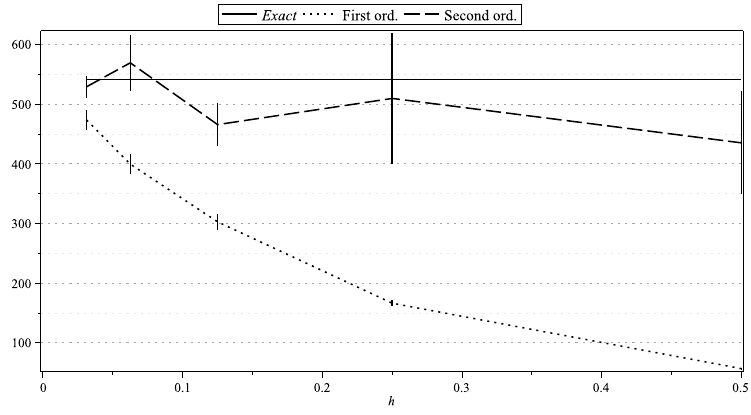
) 5 as functions of h : σ = 0.8, x 1